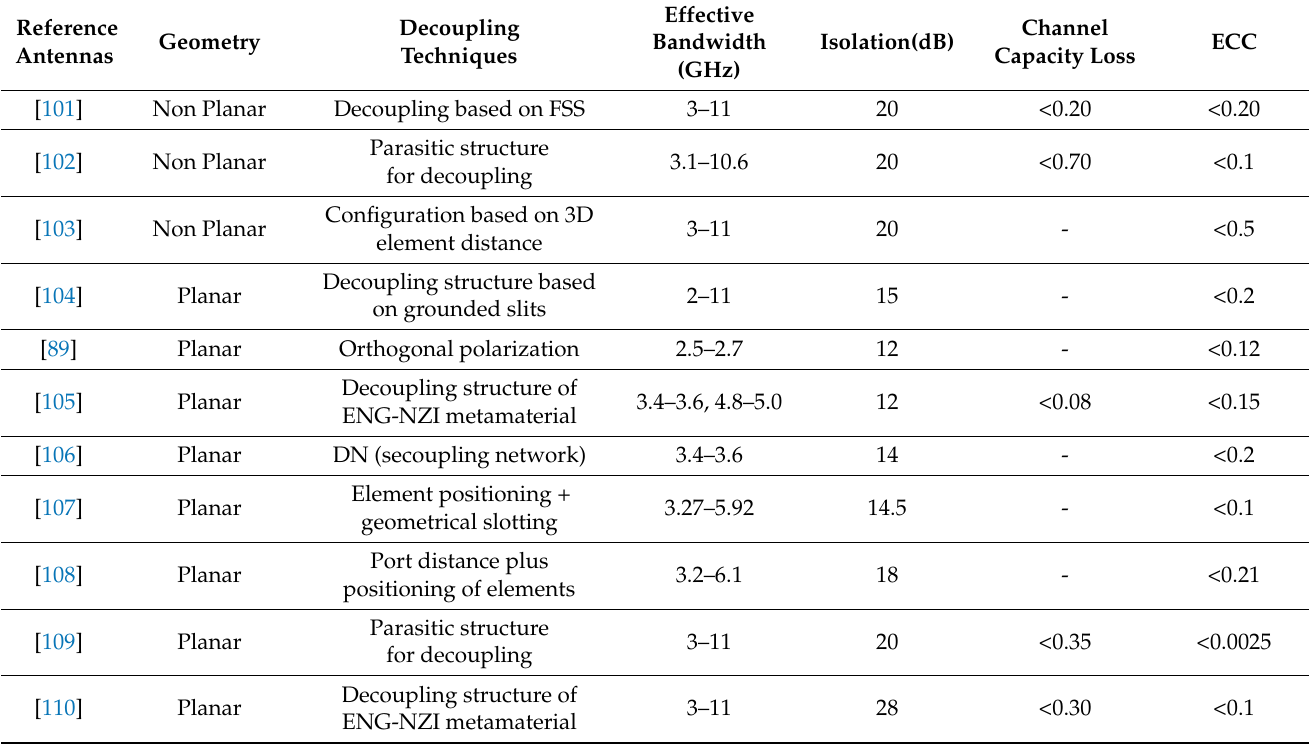
Table 6. Comparison of Different Techniques employed for Mutual Coupling